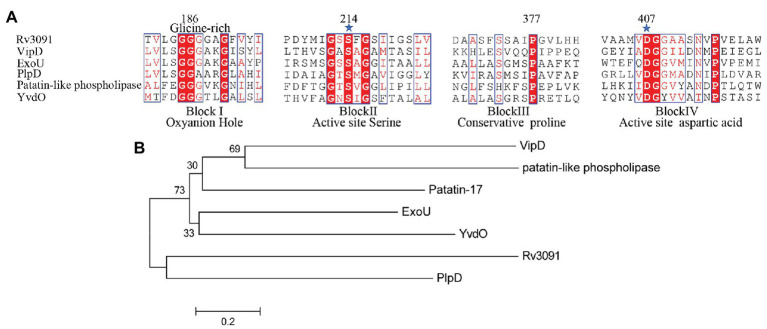
Biophysical informatics analysis of Rv3091 protein. (A) Multiple sequence alignments of the Rv3091 protein of Mycobacterium tuberculosis (Mtb) with other patatin-like phospholipases (PLPs): Vibrio cholerae Patatin-17 (TYC37870.1; Wijeyesakere et al., 2014), Legionella pneumophila subsp. VipD (YP_096826.1; Ku et al., 2012; Gaspar and Machner, 2014), Pseudomonas aeruginosa ExoU (ASM94169.1; Vanrheenen et al., 2006), P. aeruginosa PlpD (ARG85808.1; Madeira et al., 2016), Rickettsia amblyommatis str. PLP (AFC70055.1; Rahman et al., 2010), Bacillus subtilis. YvdO (QJR48018.1; Kato et al., 2010). The conserved catalytic residues Ser214 and Asp407 are indicated at the amino acid position by a star. (B) Phylogenetic tree of Rv3091 and other representative sequences of PLPs constructed using MEGA 7.0 software.